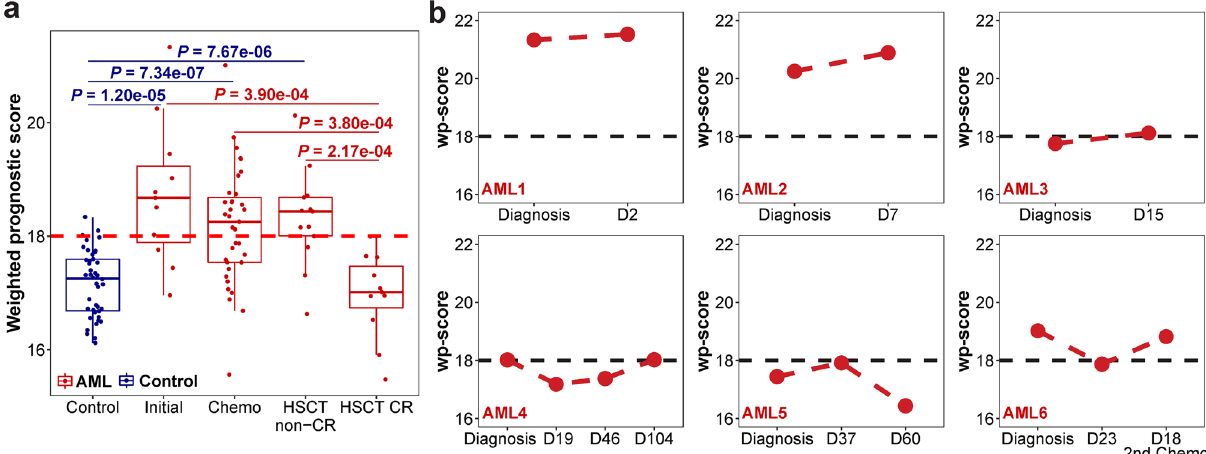
Figure 4. The survival-related 5hmC signature is associated with leukemia burden. ( a ) Boxplot of wp-scores in controls (n = 42) and patient samples at initial diagnosis (n = 11), with chemotherapy (n = 35), after receiving hematopoietic stem cell transplant not in complete remission (HSCT non-CR; n = 13) or HSCT in CR (HSCT CR; n = 11). Red dashed line represents a cutoff wp-score of 18.0 developed from training set. Center line represents median, bounds of box represent 25th and 75th percentiles, and whiskers are Tukey whiskers. ( b ) Plots of wp-scores in individual AML patients at initial diagnosis and after chemotherapy. Dx, days after initiation of chemotherapy. Black dashed line represents the cutoff